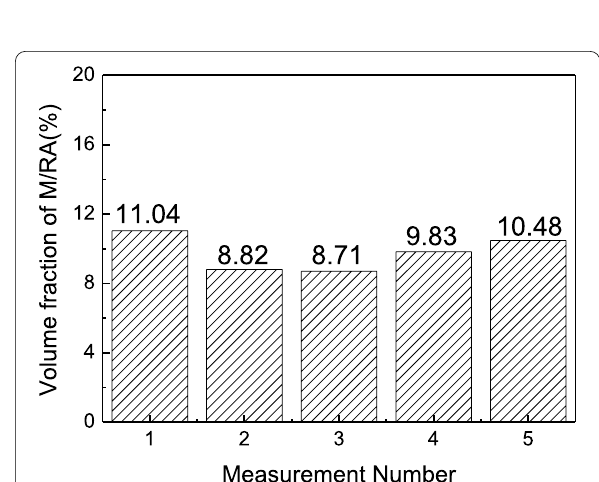
Fig. 6 Results of M/RA volume fraction measured by optical micrographs subjected to Final LePera etching conditions of 4Nb